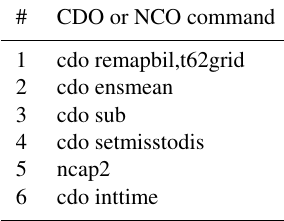
Table 3. Package commands applied in this study. Detailed infor- mation on these commands can be found in the respective netCDF Operator (NCO) and Climate Data Operator (CDO) documenta- tion online. All operations were performed with either CDO